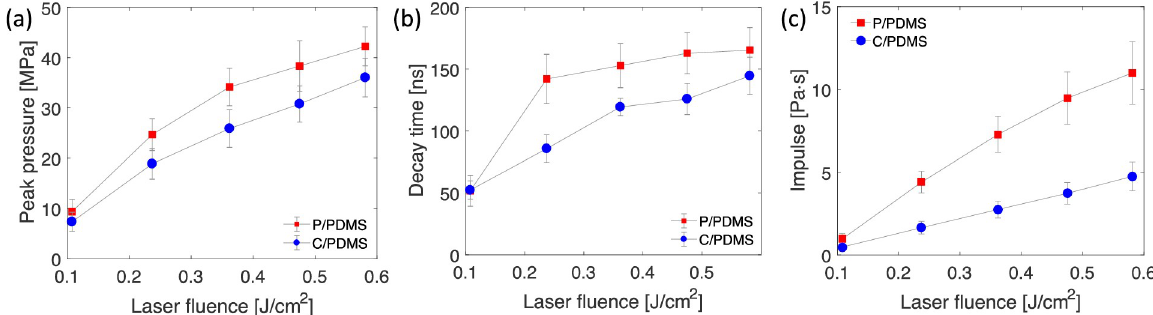
Fig 4. (a) Peak pressure versus laser fluence for the C/PDMS and P/PDMS coatings. (b) Decay time of the first peak versus laser fluence for the C/PDMS and P/PDMS coatings. (c) Impulse versus laser fluence for the C/PDMS and P/PDMS coatings. The plots in (a), (b) and (c) show results summarized from four independent tests. The error bars indicate the standard deviations from four independent tests with the same setup and conditions.